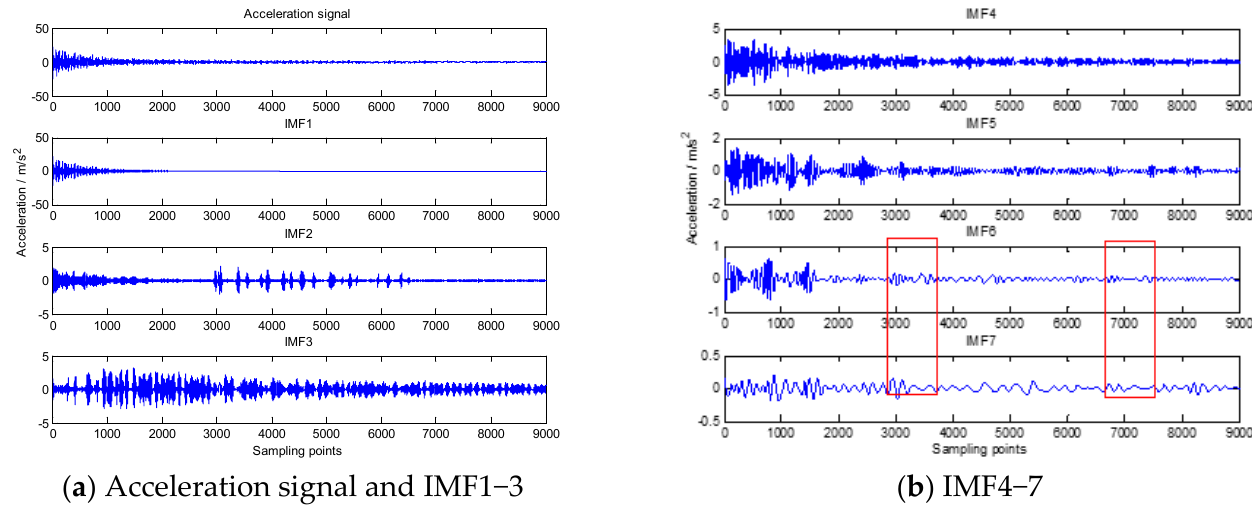
Figure 14. Acceleration signal and IMF1−7 using EMD.